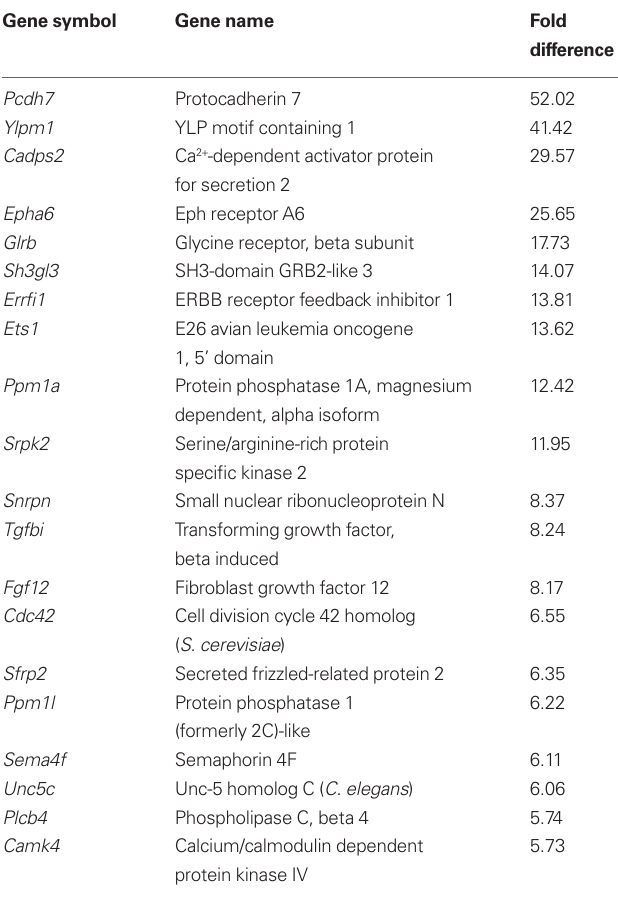
Table 1 | Top 20 upregulated genes in the migrating